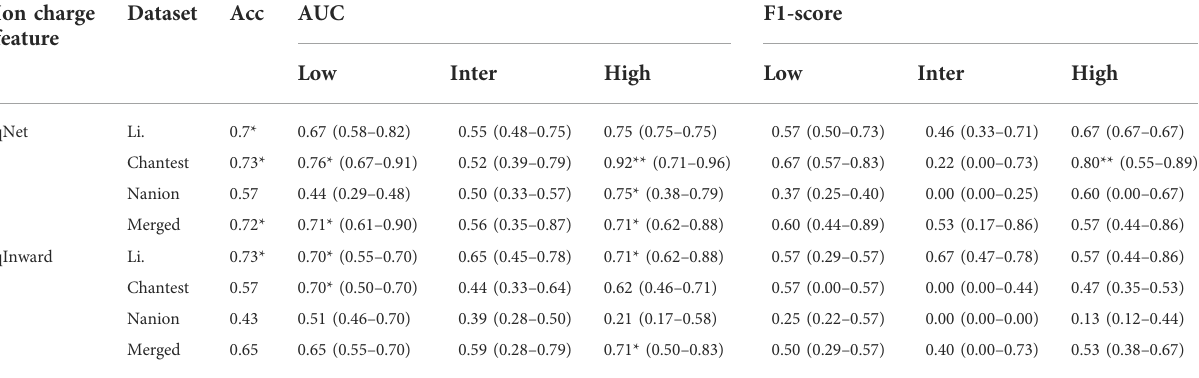
TABLE 5 Summary of classi fi cation performance using ion charge features; classi fi cation performances according to the AP features shows the median, minimal and maximal values after evaluating the model through the 10,000-test algorithm; AUC, the area under the receiver operating curves; Merged, the combined set containing all three datasets; ACC, accuracy; One asterisk (*) denotes the intermediate performance over 0.7 of median values, and two asterisks (**) denote the excellent performance over 0.8 of median